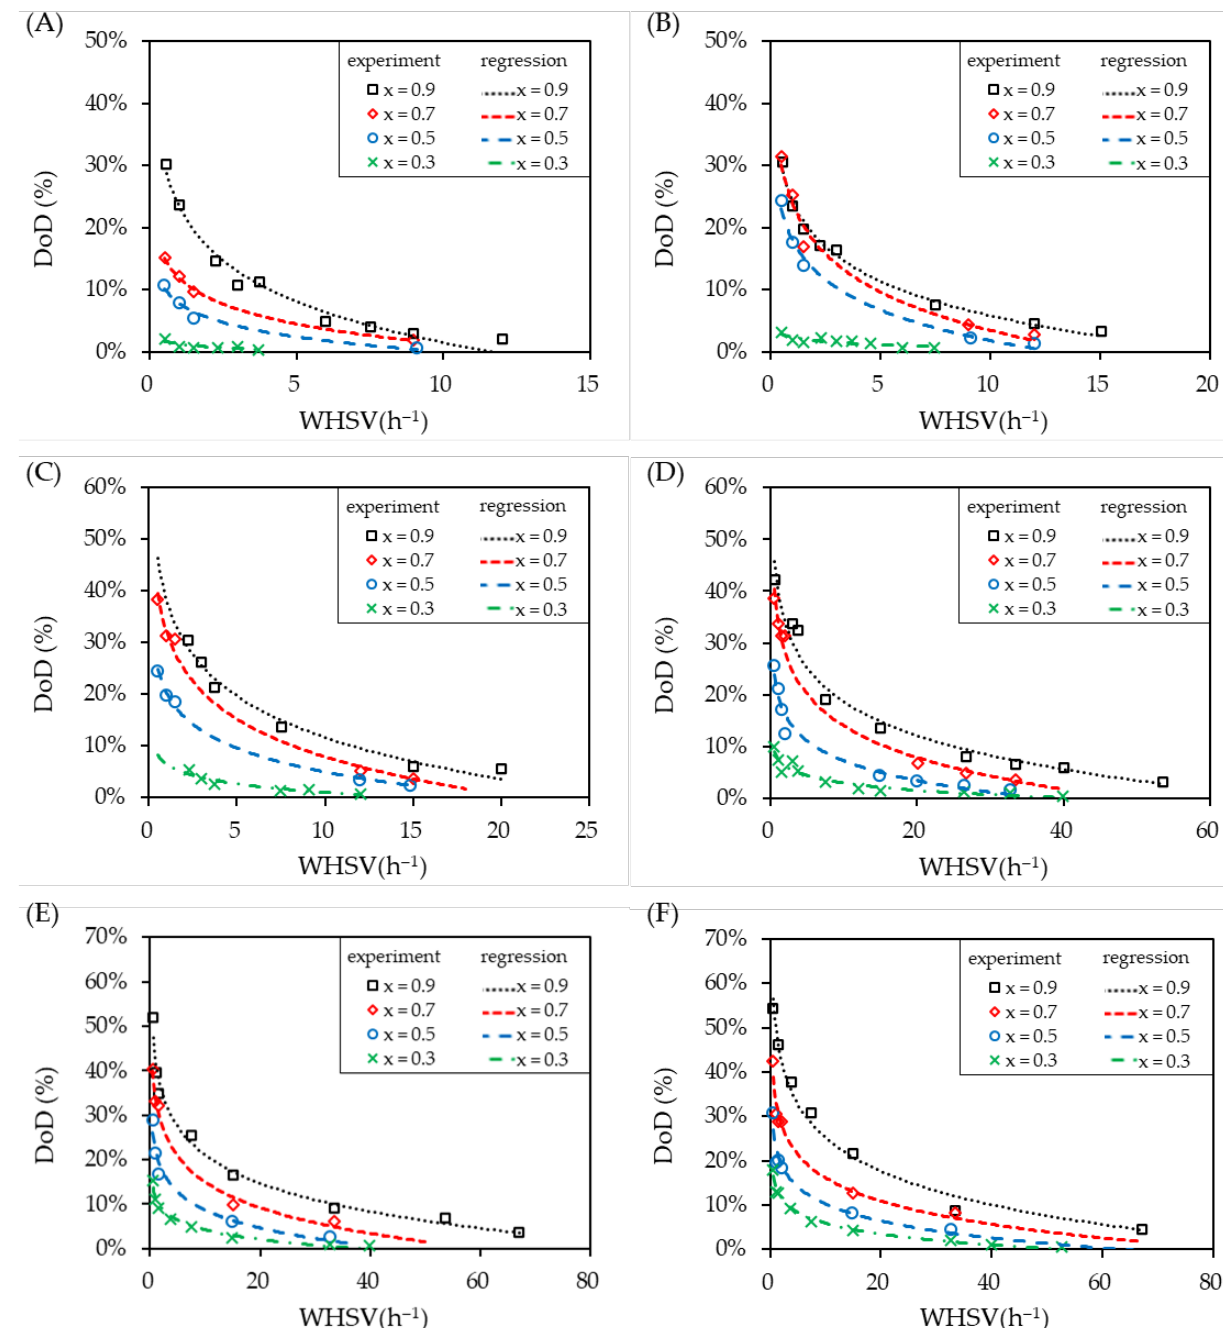
Figure 8. Effect of LOHC+ on the degree of dehydrogenation (DoD) due to the variations in WHSV at the initial concentration (𝑥) and at reactor temperatures of ( A ) 270 °C; ( B ) 280 °C; ( C ) 290 °C; ( D ) 300 °C; ( E ) 310 °C; and ( F ) 320 °C.